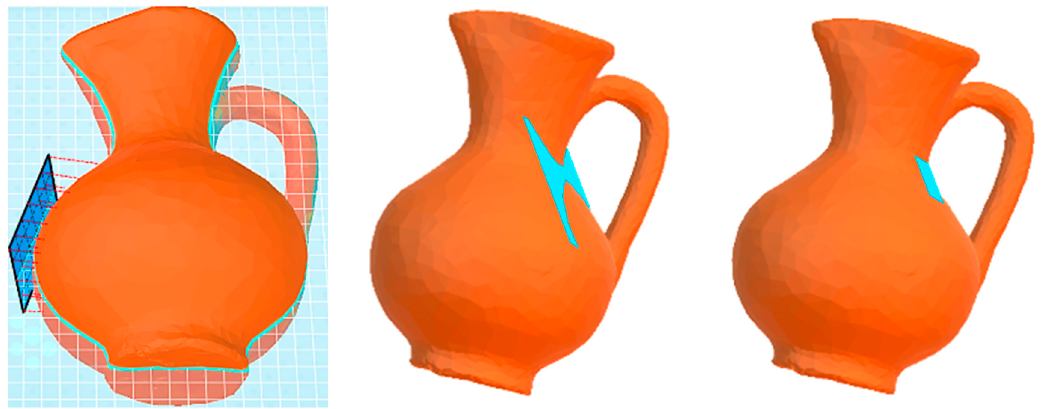
Figure 3. Adaptive modification of tactile sensor